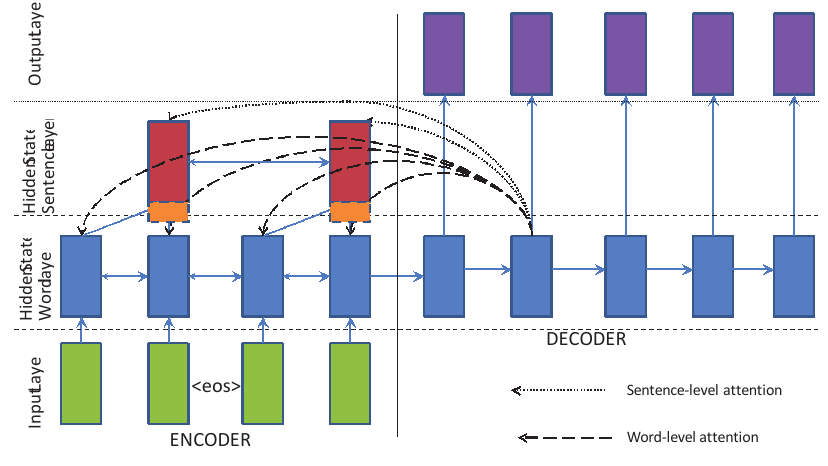
Figure 1. Model framework of hierarchal attention